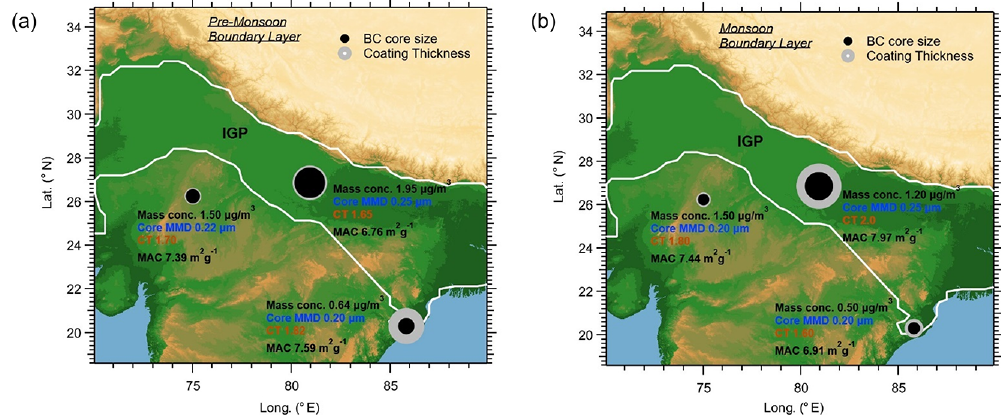
Figure 2. Pre-monsoon (a) and monsoon (b) average boundary layer (BL) black carbon optical and physical properties, across northern India. The BC core and coating information is presented for NW India between Jaipur and Jodhpur, the central IGP, and NE India near Bhubaneswar. The IGP boundary (white line) is from Kumar et al. (2018). Map terrain created using Global multi-resolution terrain elevation data 010 (GMTED2010)